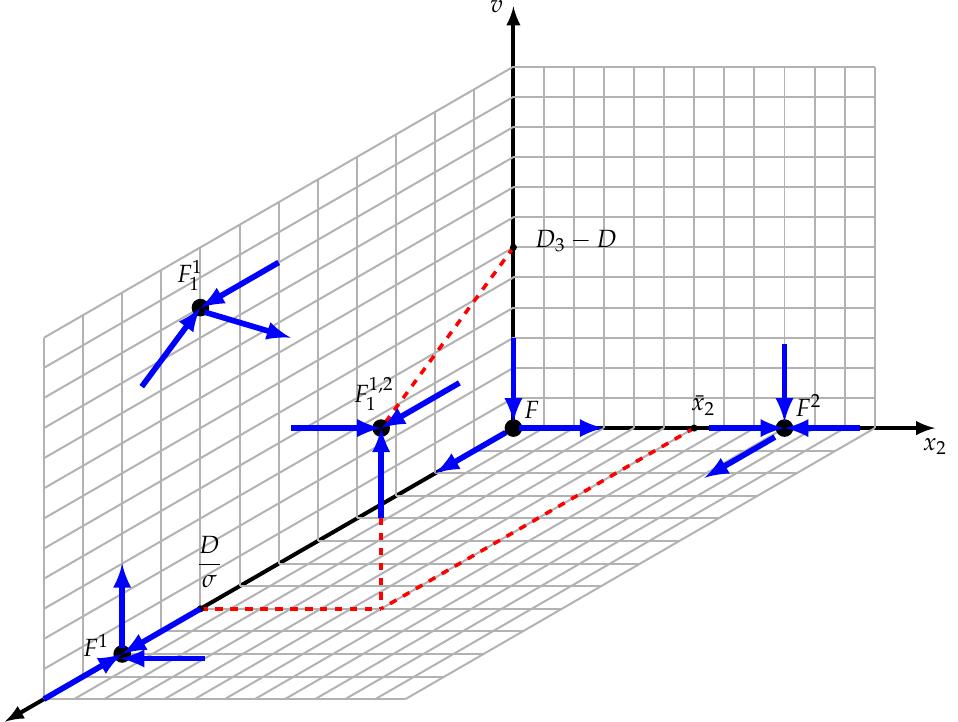
are saddle points; however, F 1,2 1 are saddle points, however, F 1,2 1